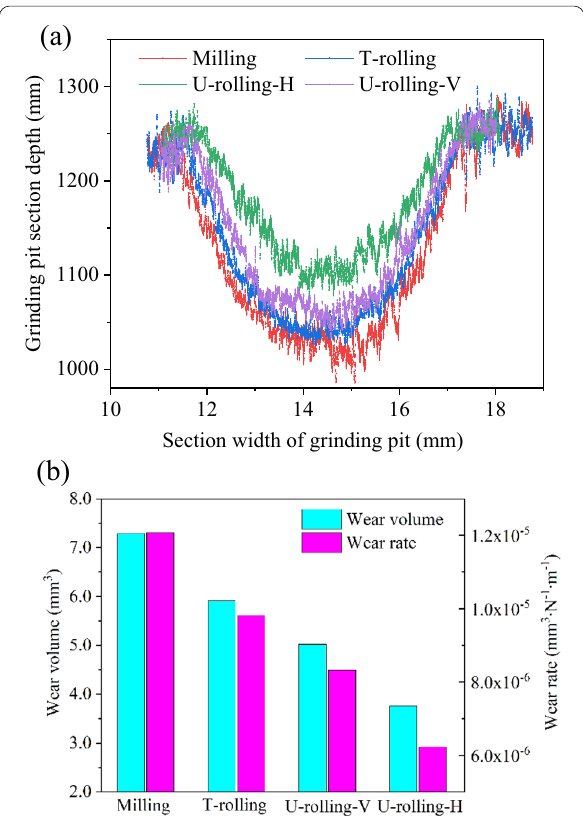
Figure 12 Wear properties of samples: ( a ) Grinding pit profile, ( b ) Wear volume and wear rate